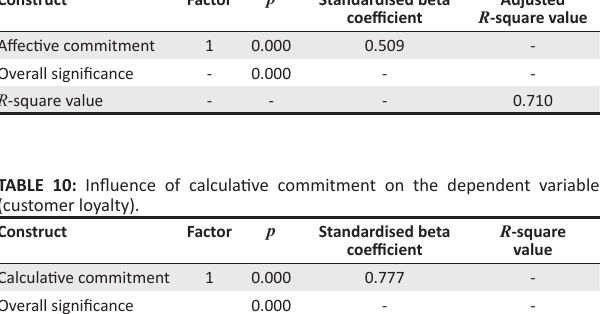
TABLE 9: Influence of affective commitment on the dependent variable (customer loyalty). Construct